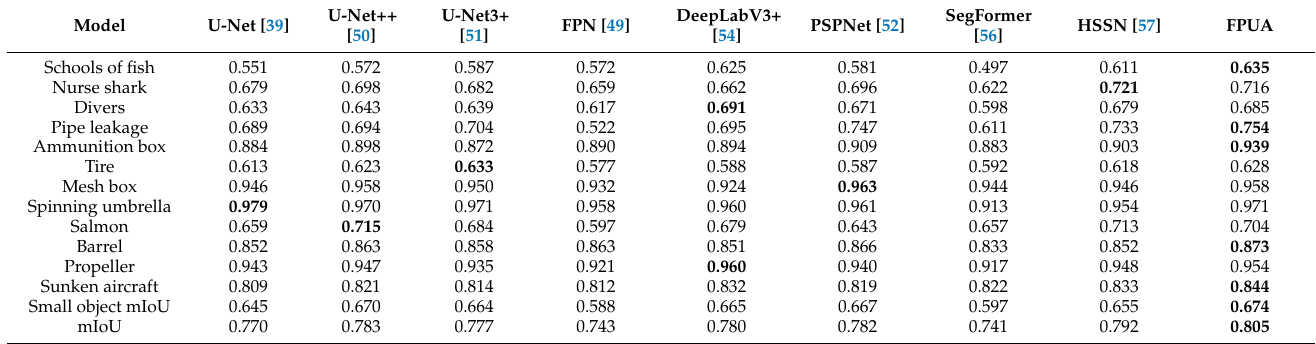
Table 7. The mIoU results for each class of each model under real data. The best segmentation accuracy for each class is marked